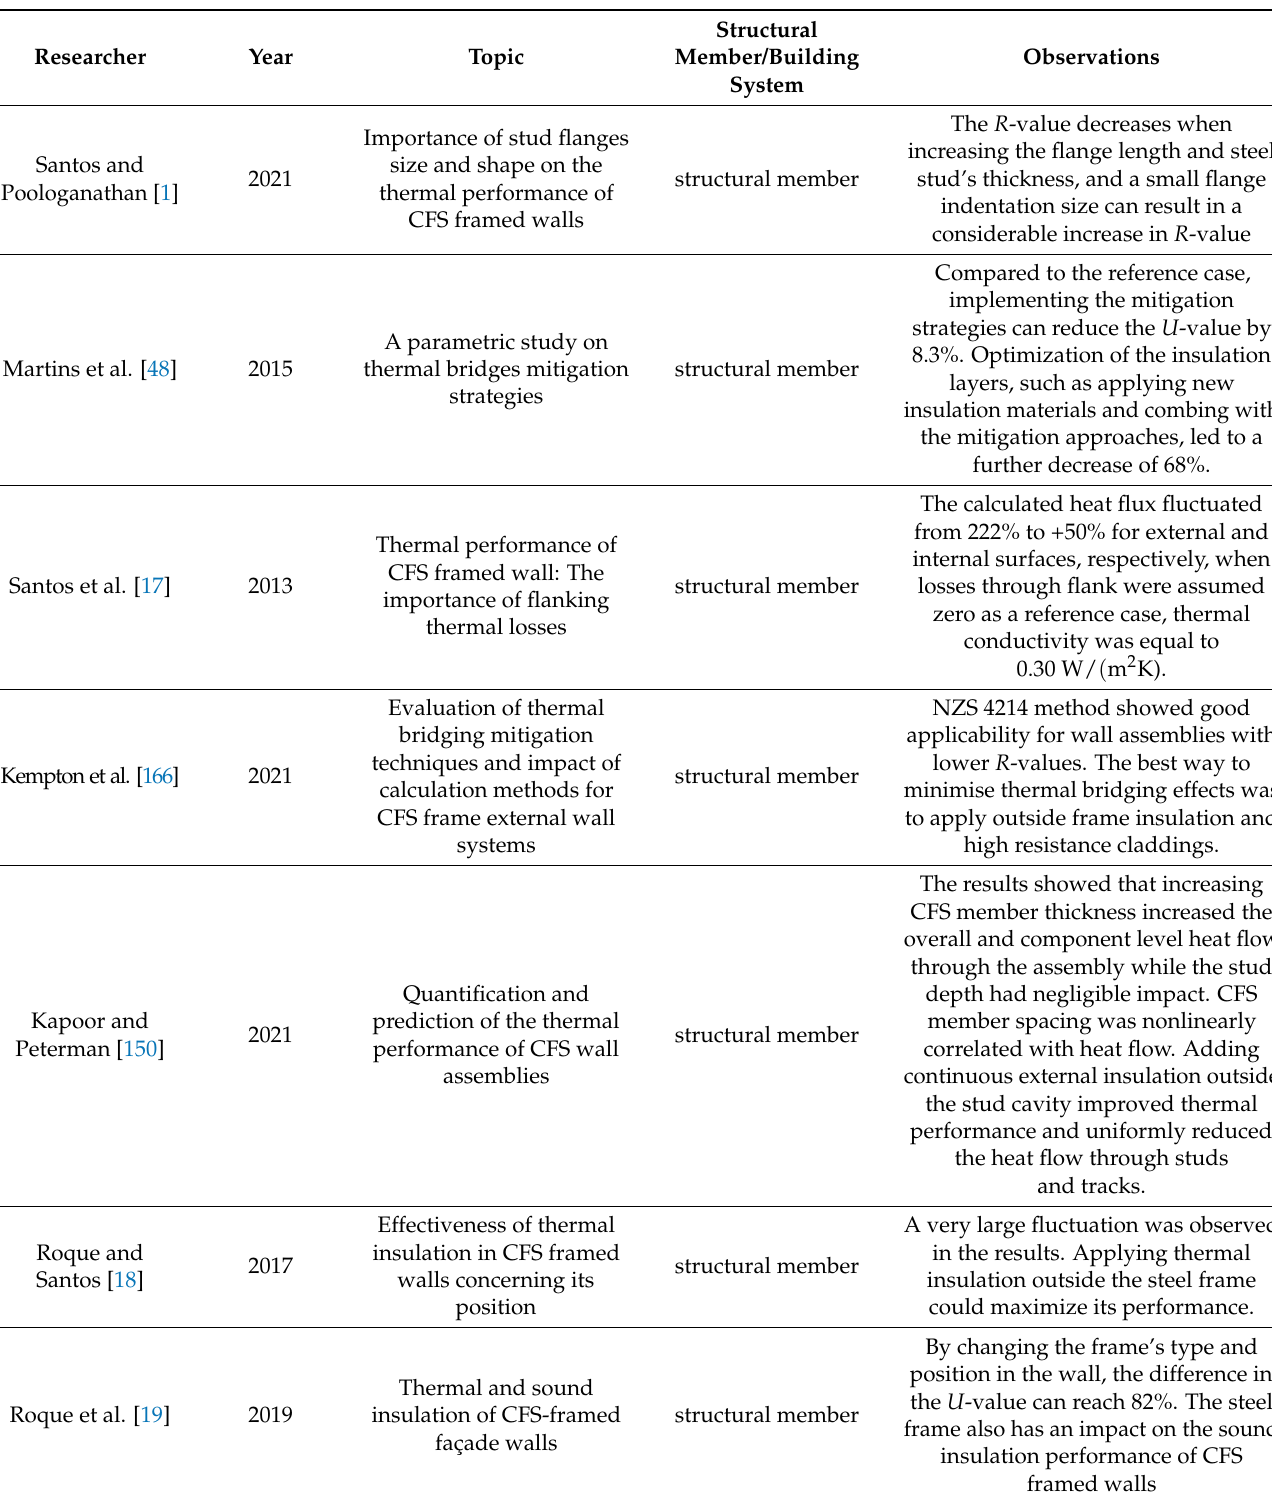
Table 2. Summary of the important research papers analyzing the thermal performance of CFS